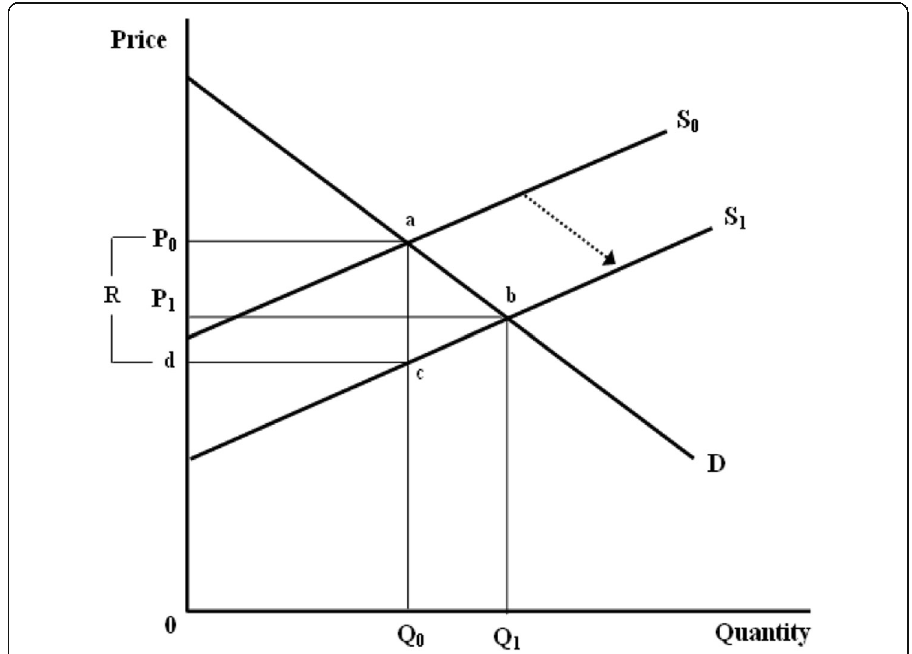
Fig. 1 Impact of innovation on economic surplus. Source: Adapted from Norton et al.